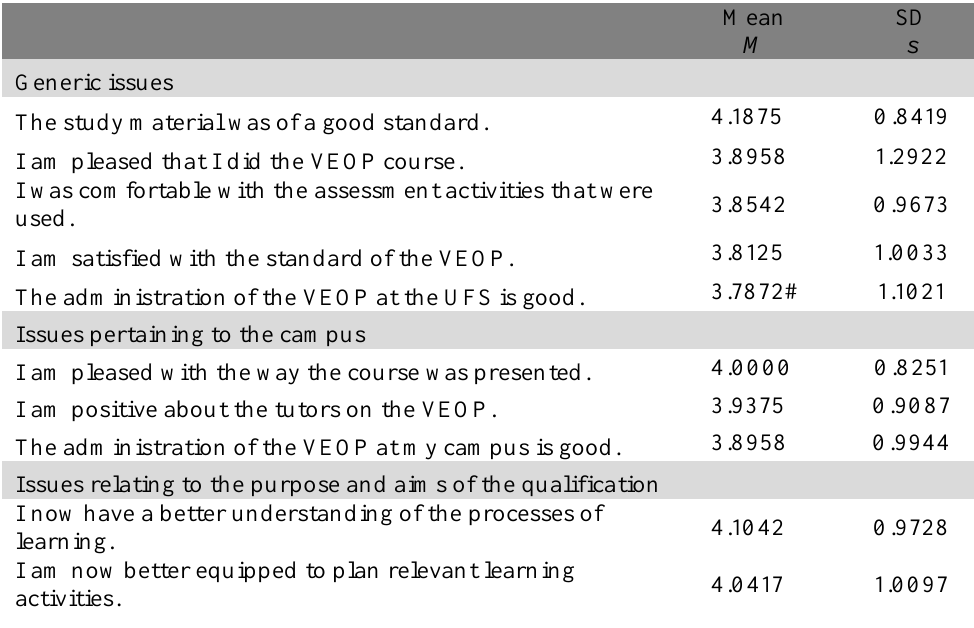
Details, Relating to the Issues, on which Participants were Probed (Ranked per